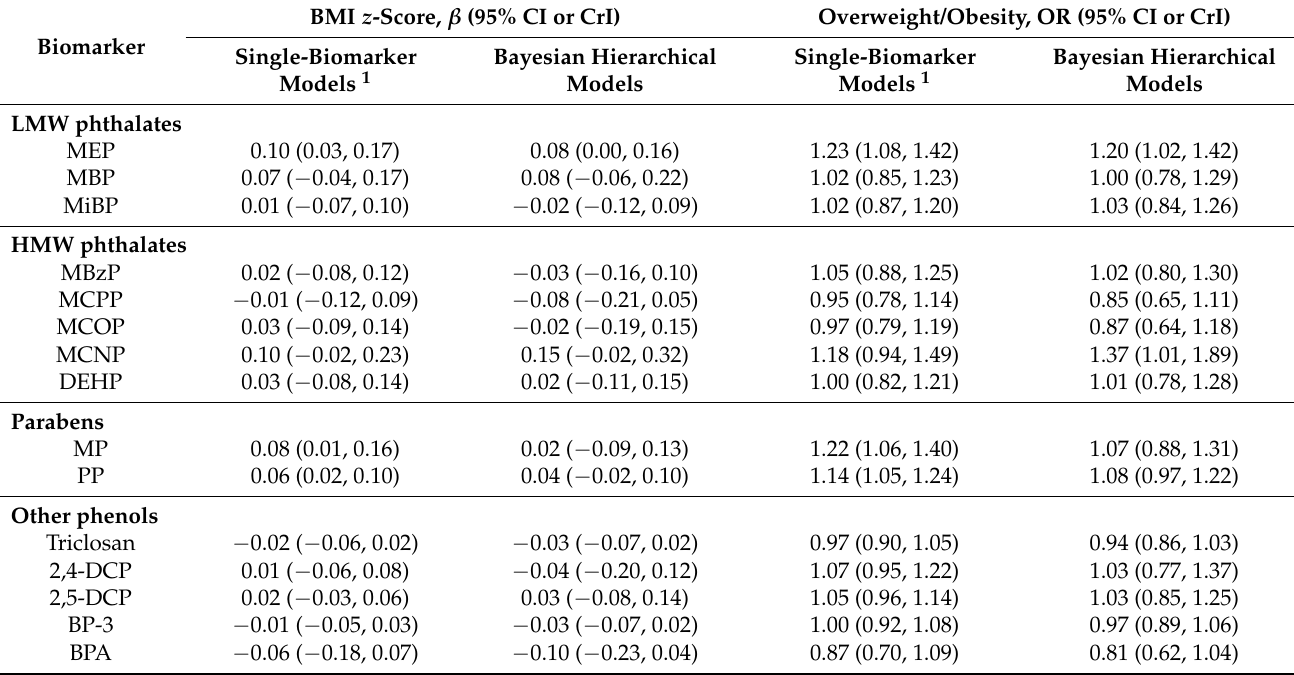
Table 3. Associations between biomarkers and BMI or overweight/obesity in single-biomarker regression models and Bayesian hierarchical models ( N =